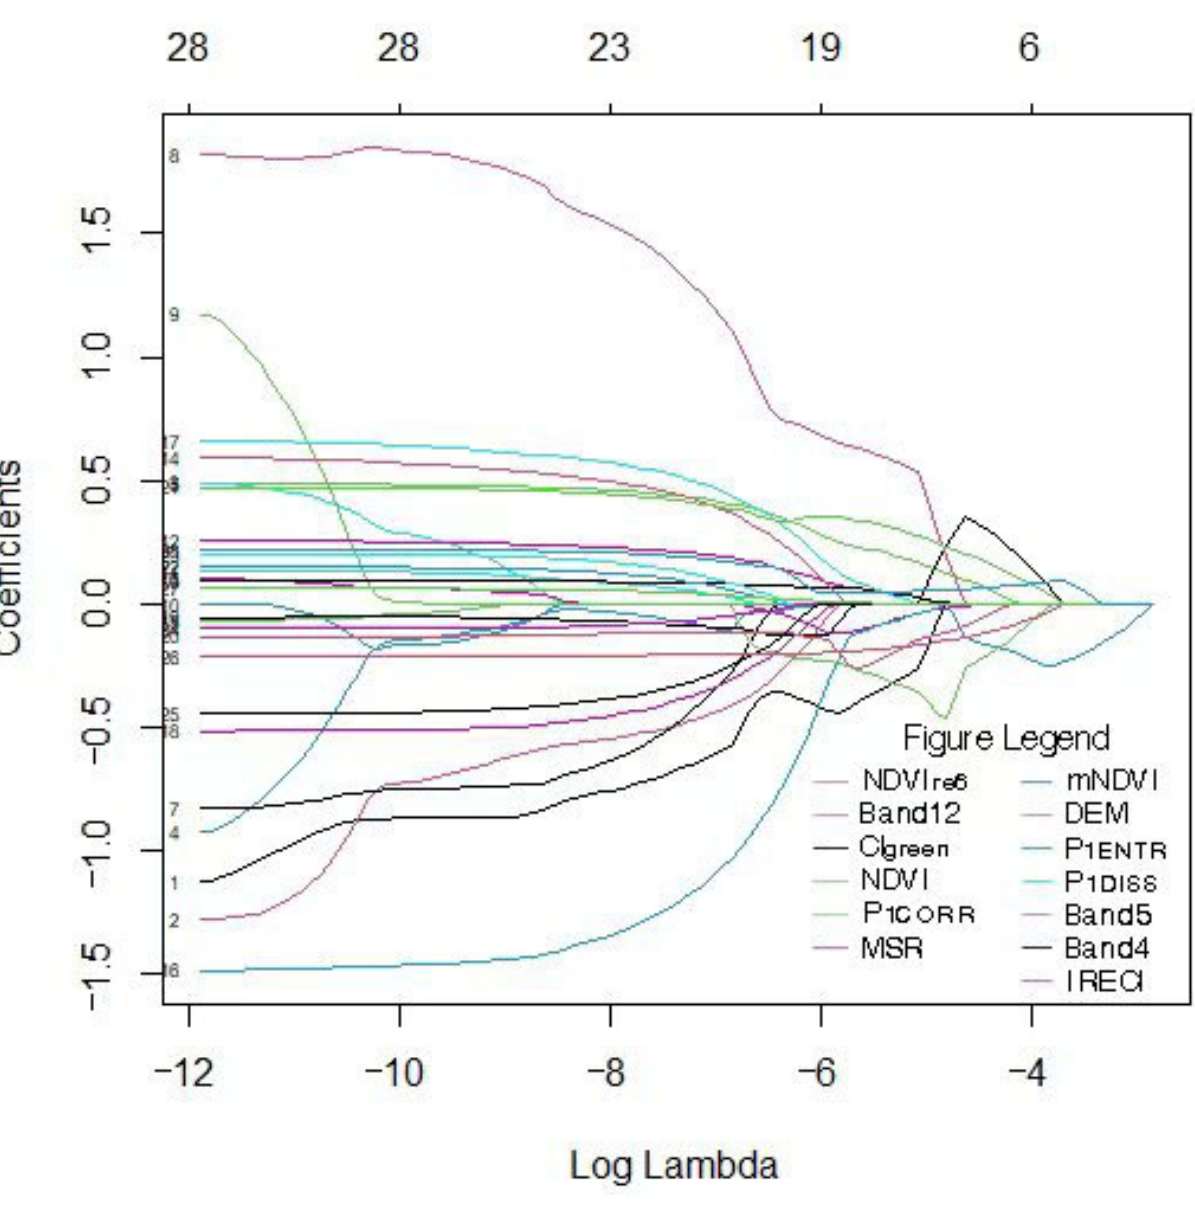
Figure 4. Glmnet package filter variables.